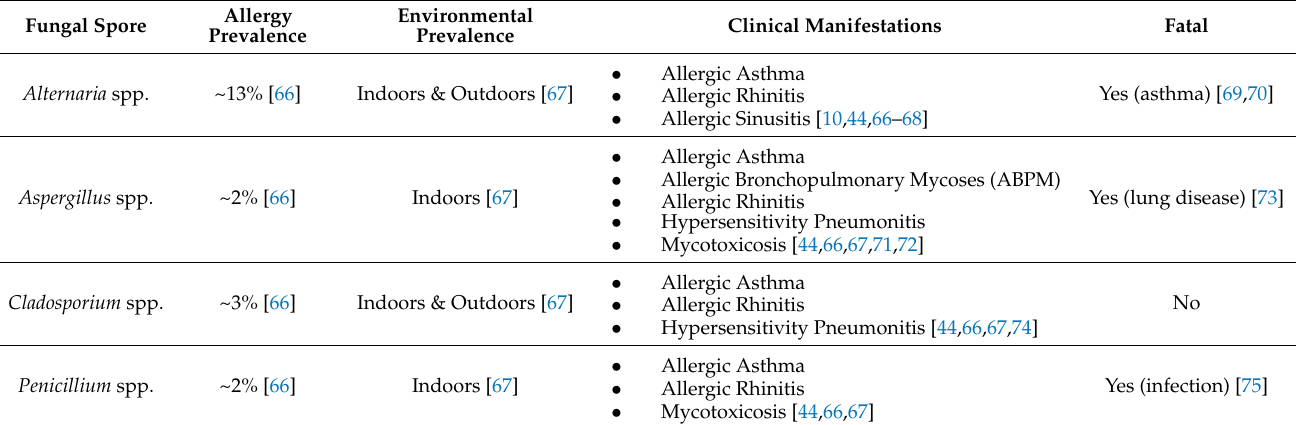
Table 1. Prevalence and clinical symptoms of prominent allergenic fungal